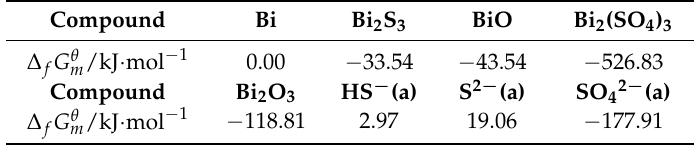
Table 4. The standard Gibbs free energy of formation for species considered in Figures 11 and 12.